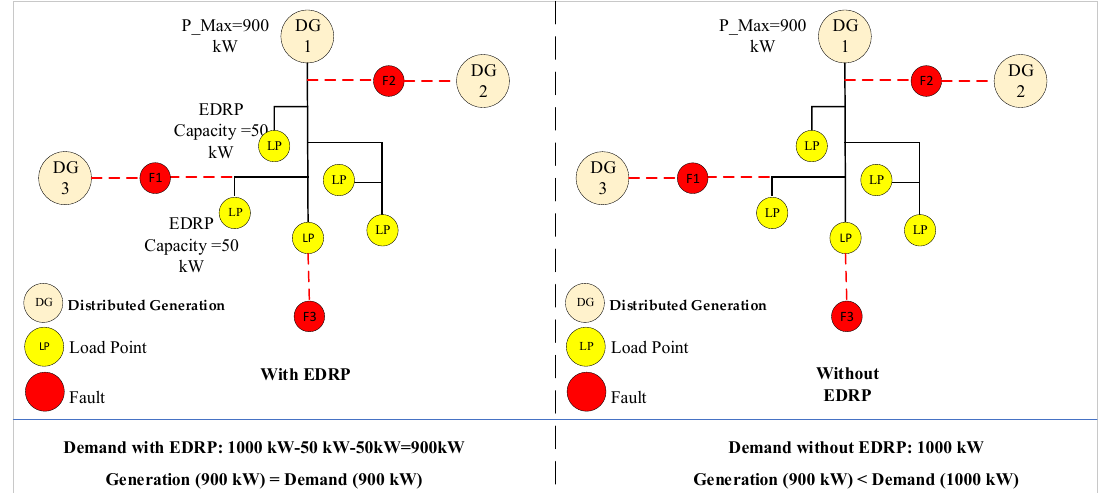
Figure 1. The power distribution system with and without Emergency Demand Response Program The power distribution system with and without Emergency Demand Response (EDRP). Program